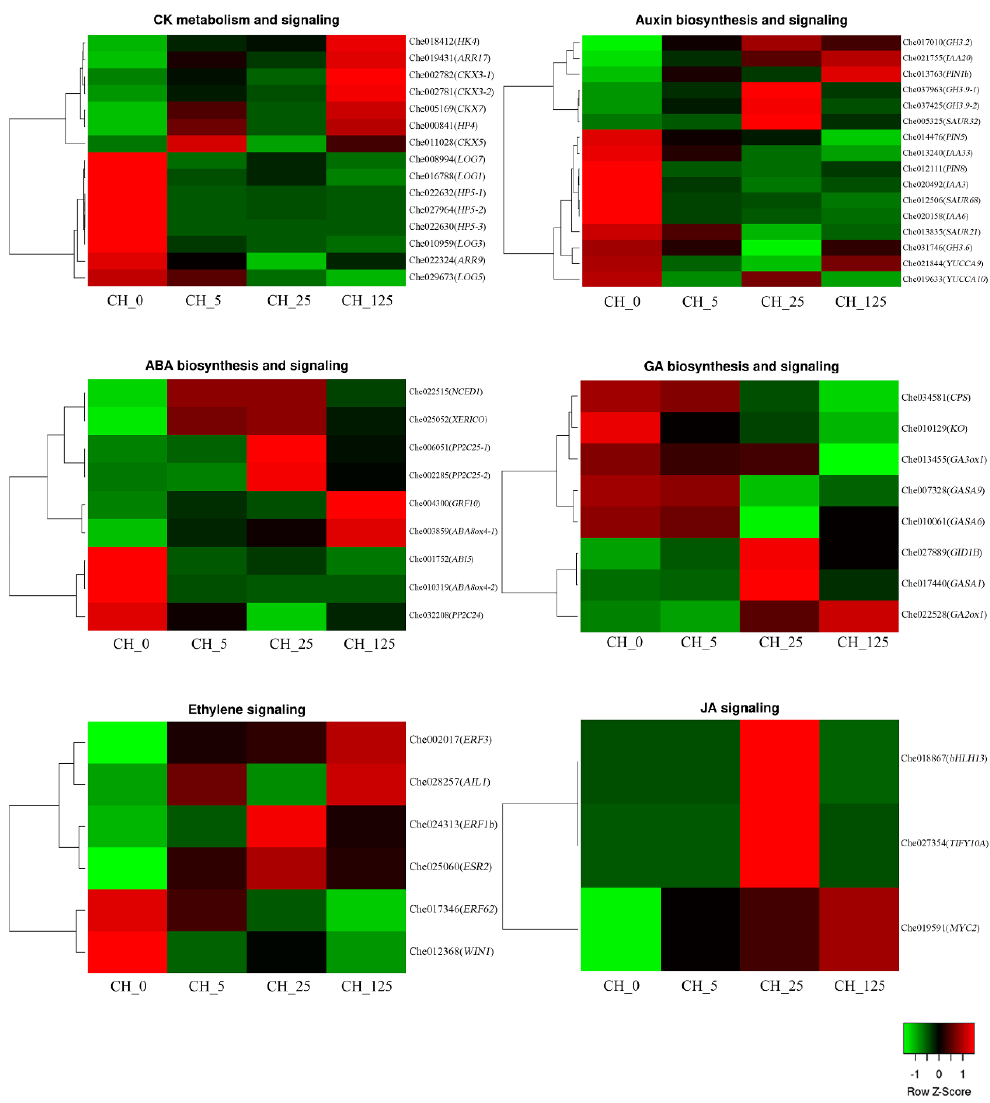
Figure 9. Hierarchical clustering of DEGs associated with biosynthesis, metabolism and signal transduction of cytokinin, auxin, abscisic acid, gibberellin, ethylene and jasmonate.